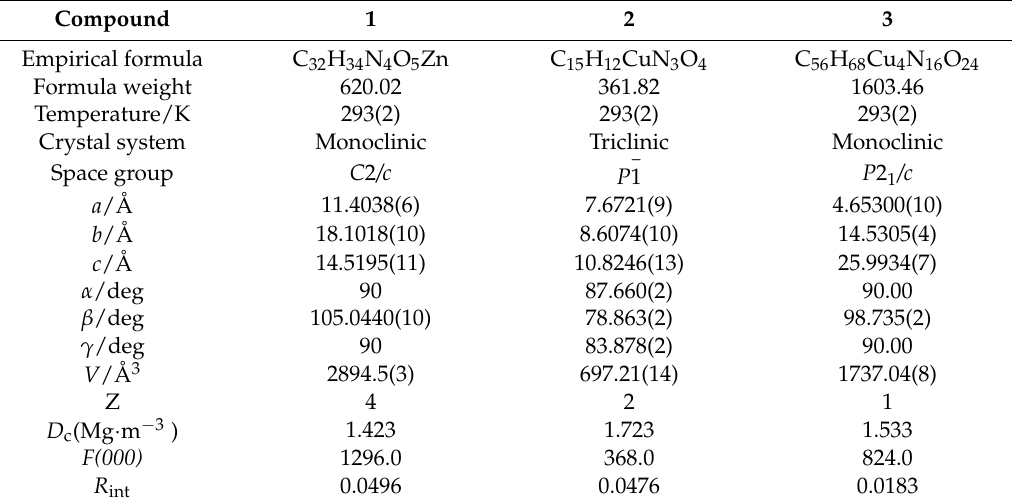
Table 1. Crystal data and structure refinement details of compounds 1 –